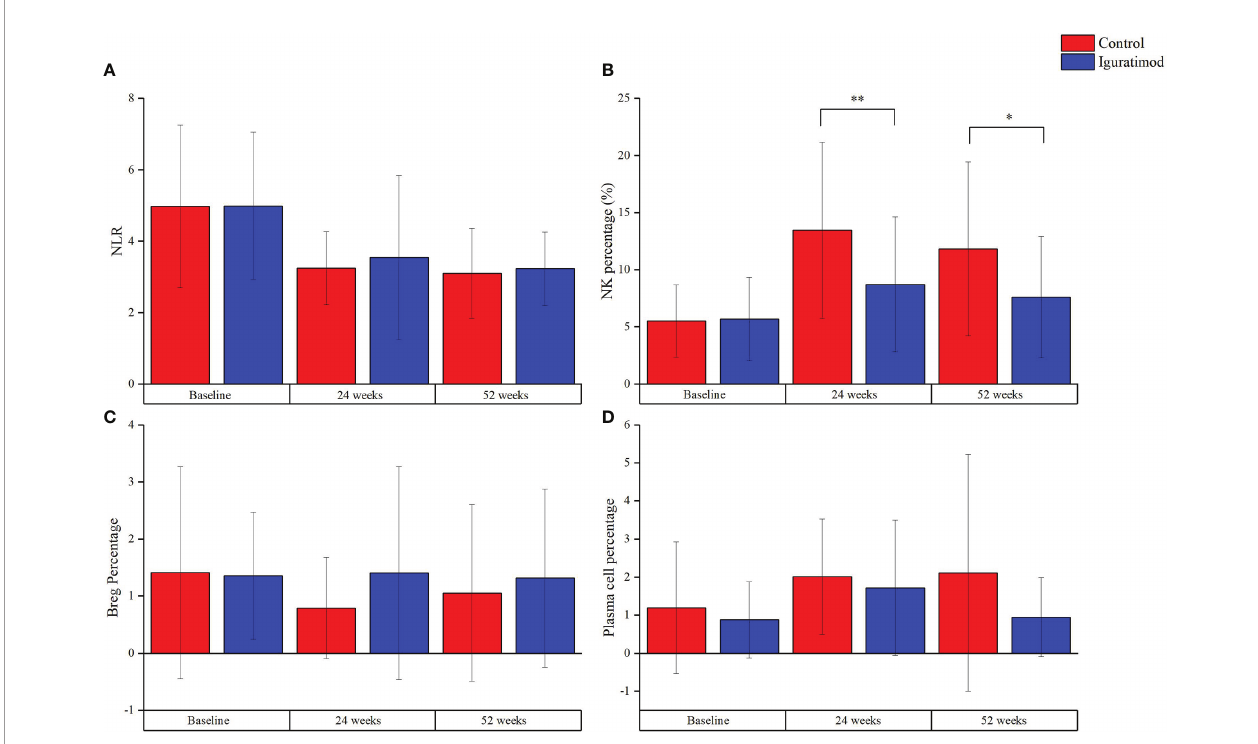
FIGURE 5 | Explorative outcomes at 24 weeks and 52 weeks. (A) Neutrophil-to-Lymphocyte ratio, indicating the general in fl ammation status, decreased with follow- up in both groups. However, there was no statistical signi fi cance for the difference between the group ( P = 0.76). (B) The percentage of NK cells, which were CD56 + CD16 + cells measured with fl ow cytometry, was lower in Iguratimod group than that in the control group at 24 weeks (** P < 0.01) and 52 weeks (* P = 0.01). (C, D) represented regulation B (Breg) cells (CD19 + CD24 + CD38 + ) and plasma cells (CD19 + CD24 - CD38 + ), respectively. There was a trend of higher percentage of Bregs and lower plasma cells in Iguratimod group. But our study was not powerful enough to check it (both P >